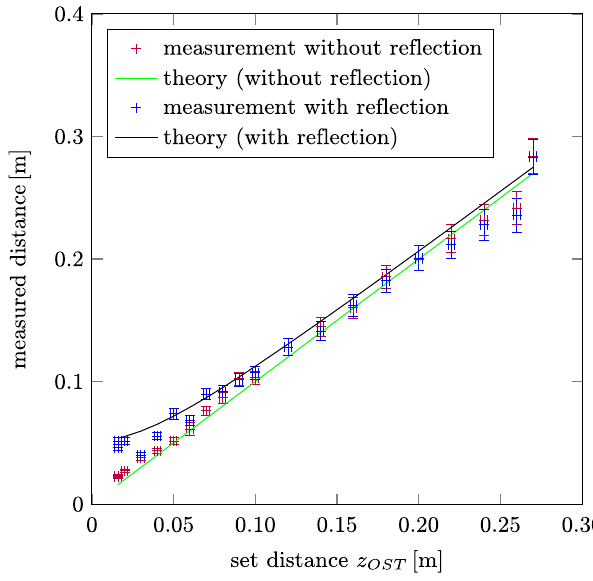
FIG. 13. Without reflection (red crosses) the path length P SoSe follows the expected linear behavior (see also Fig. 10). Reflected Second Sound (black crosses) has a longer path length P SoSe , according to the distance to the wall. The difference in the path length’s P SoSe shrinks with increasing z OST , as the direct and reflected path length gets more